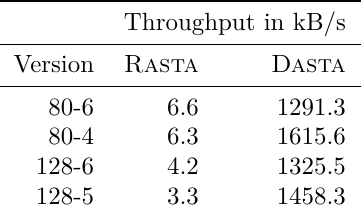
Table 3: Performance comparison of Rasta and Dasta in the offline key stream generation on Intel(R) Xeon(R) CPU E3-1230 v6 @ 3.50GHz with 32GB of RAM.